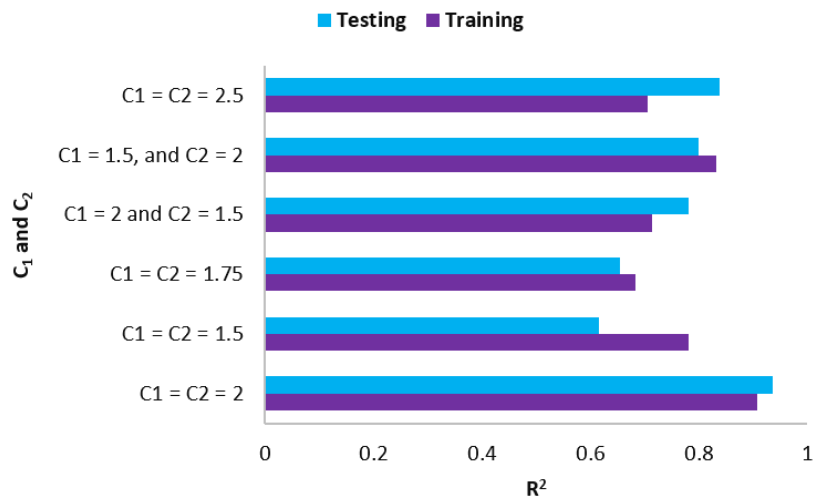
Figure 10. C 1 and C 2 results in PSO-ANN models.